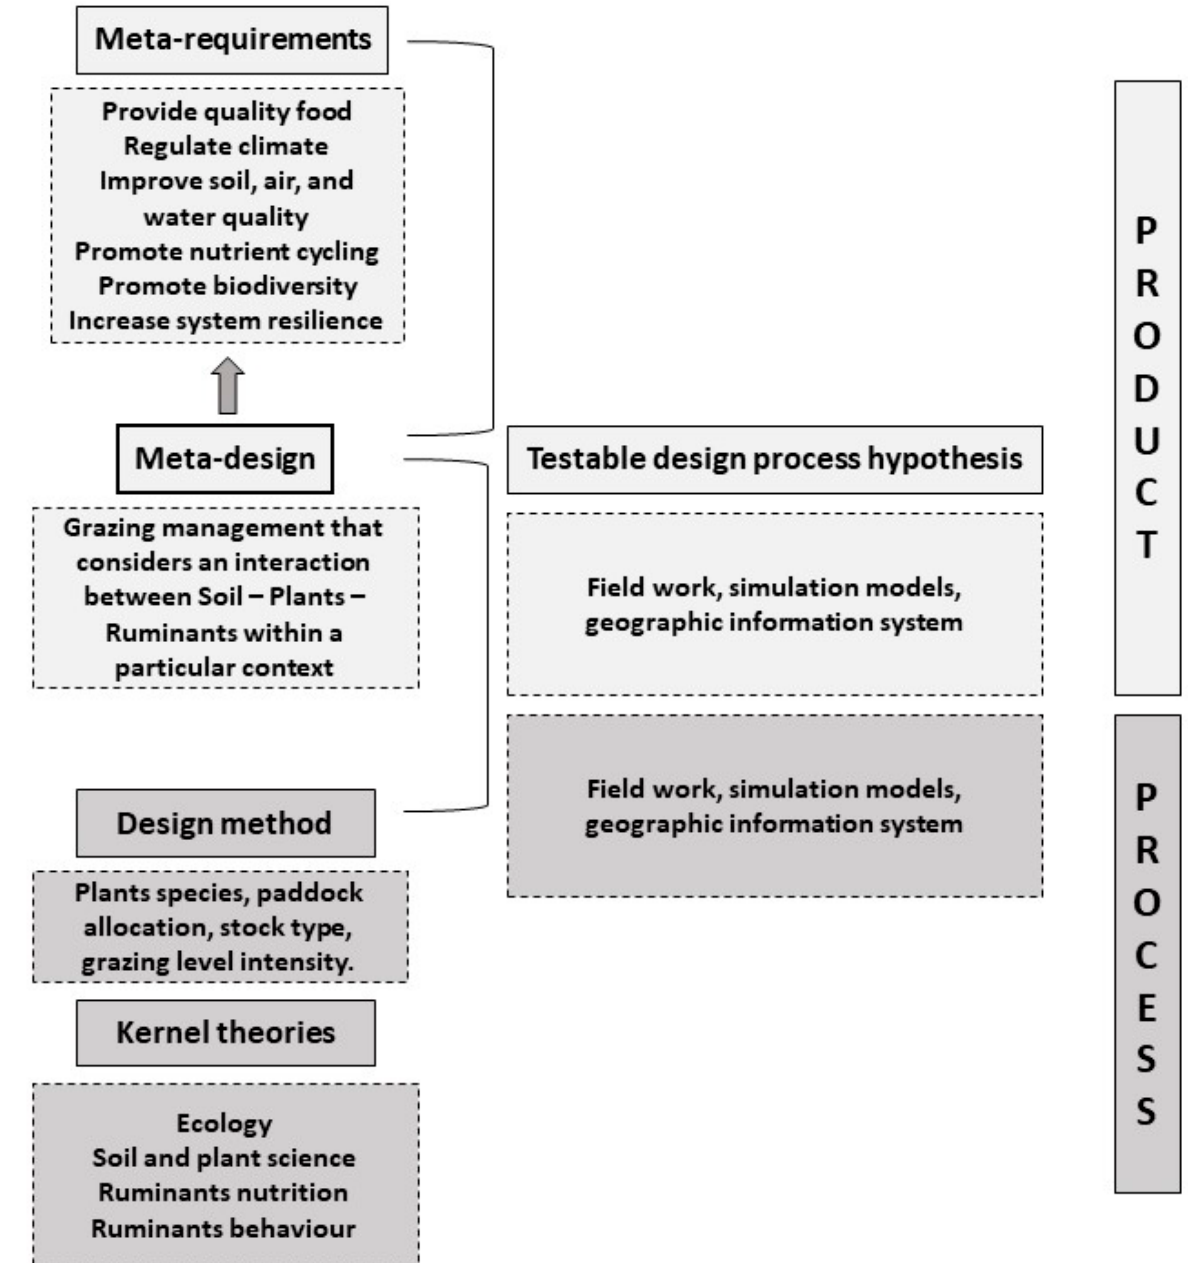
Figure 3. The design framework to diagnose and enhance grassland health under pastoral livestock production systems based on the design theory proposed by Walls et al., 1992.